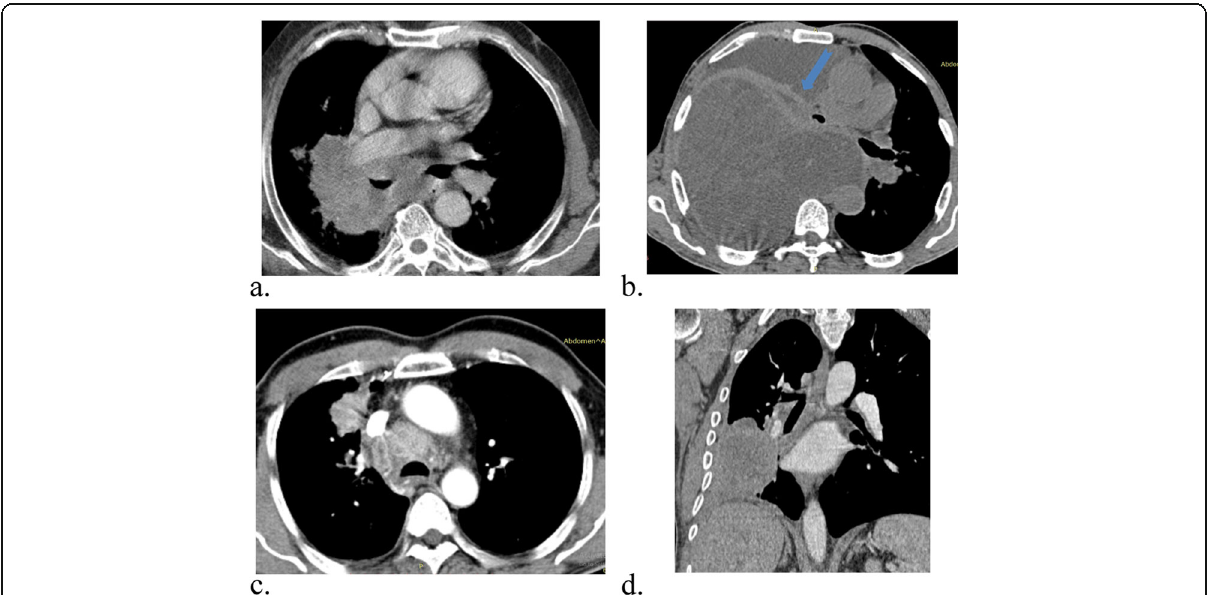
Fig. 4 Four different tumors in the current study. a Small cell carcinoma appearing as a hilar mass showing internal necrosis, encasing the main bronchus with direct invasion of the mediastinum. b Lung sarcoma manifested as low attenuation mass lesion occupying the right hemithorax with the involvement of the mediastinum and pleura, the right lung is seen collapsed (arrow) with the mediastinum is seen displaced to the contralateral side. c Large cell carcinoma is shown as a lobulated soft-tissue attenuation mass lesion with loss of clear line of cleavage with the mediastinum and sizable mediastinal nodes. d Carcinoid tumor is shown as a well-defined homogeneous lesion with inseparability from the pleura extending to the hilum with infiltration of the middle lobe bronchus (not